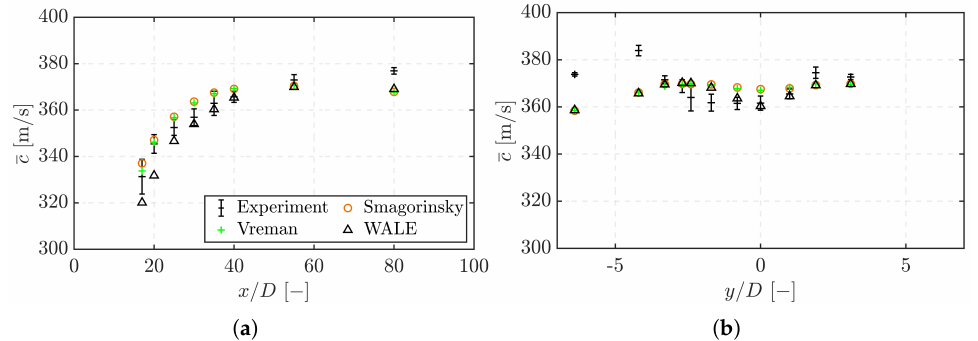
Figure 9. Comparison of the mixture speed of sound of LES studies using different sub-grid scale models (color) and the experiment (black) for the cases SoS _1 in the axial direction ( a ) and in the radial direction at the position x / D = 35 ( b